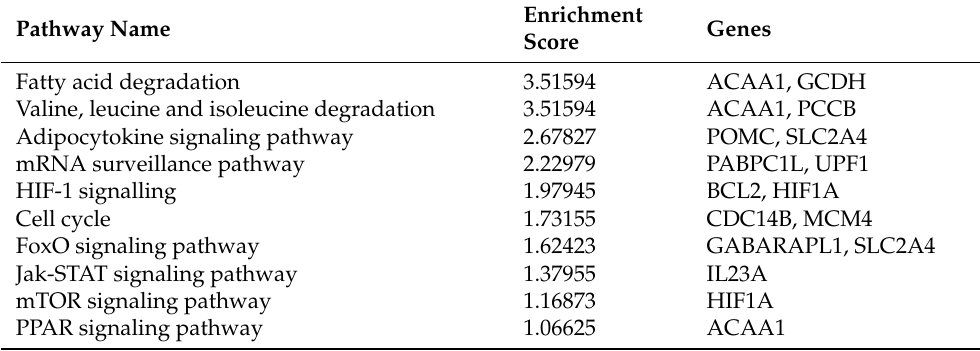
Table 2. Selected pathways for C1QBP-mediate cell proliferation and growth (with enrichment score >